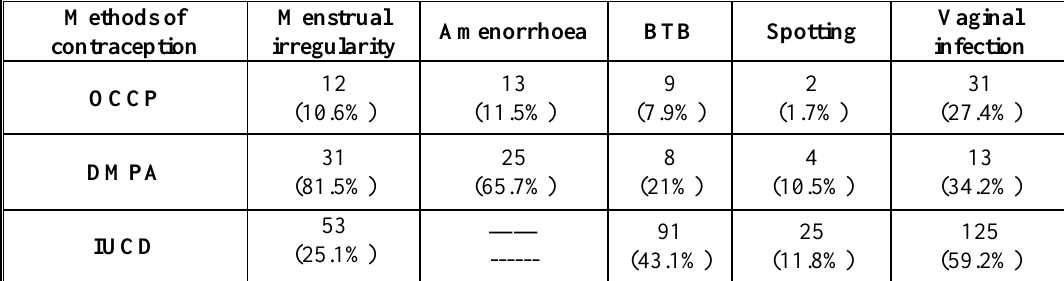
Table 2 : Number of subjects (and their percentage) used different contraceptive methods showed gynaecological adverse effects.